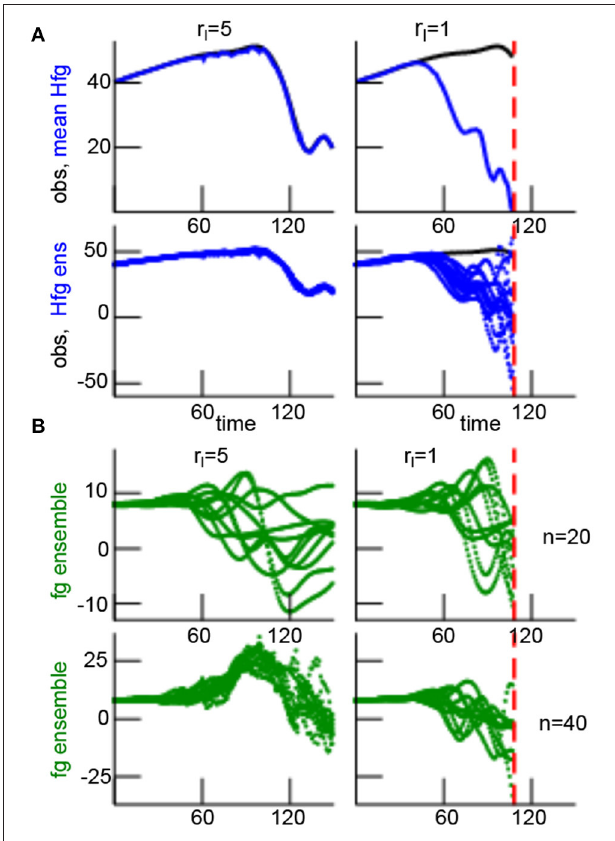
FIGURE 3 | Temporal solutions of the filter process with r H different localization radii r l . (A) Comparison of observations (black line) and model equivalents in the observation space of the ensemble mean y b [top row, solid blue line, denoted as Hfg for model equivalent (H) of the first guess (fg)] and the ensemble members y ( b , l ) (bottom row, dotted blue line). The time represents the number of analysis steps. (B) First guess (fg) ensemble members in model space at the single spatial location n panel), i.e., outside the observation area with H 1 n location n 40, i.e., in the center of the observation area (shown in bottom =